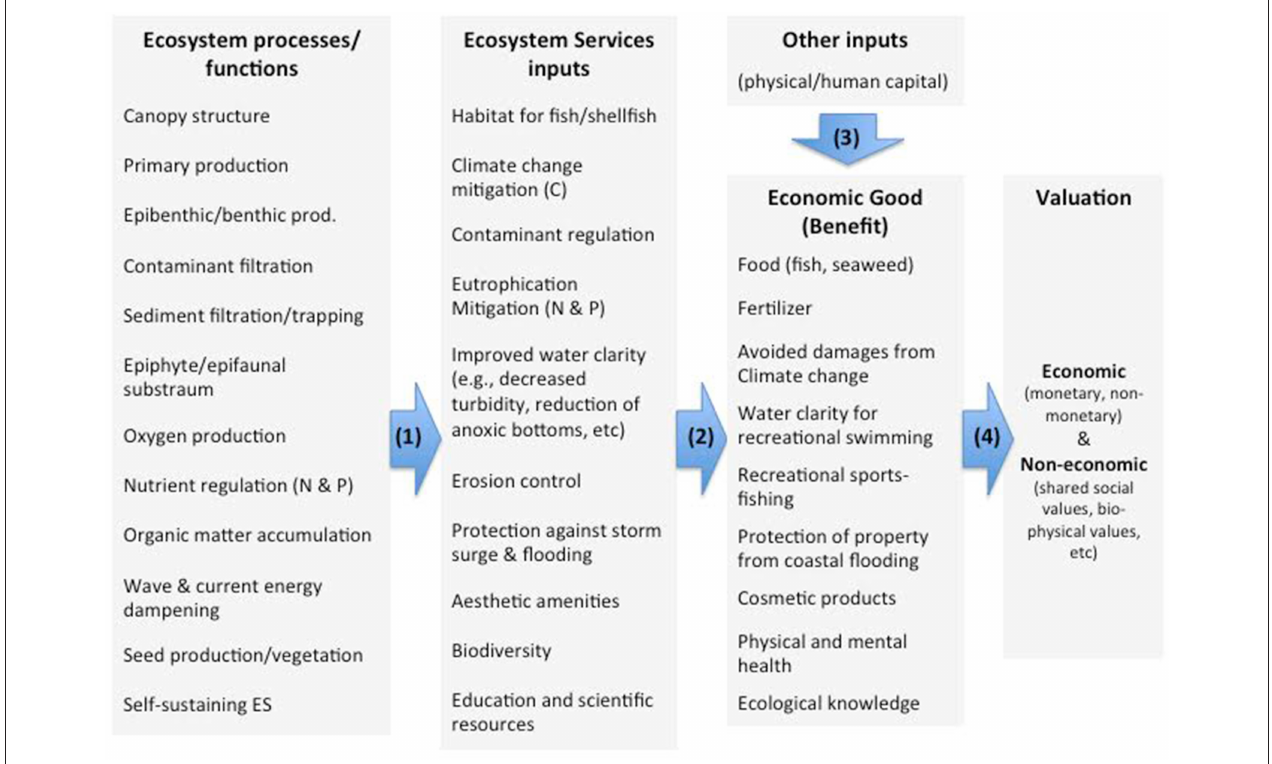
FIGURE 1 | Conceptual approach to identifying and valuing seagrass benefits to society. We follow a four step process: Step #1 maps relevant ecosystem functions and links them to economic goods [arrows (1) and (2)]. Step #2 identifies biophysical changes in ecosystem functions [first column] that are to be valued and Step #3 identifies how these changes affect the flow of multiple ecosystem services and economic goods [arrows (1) and (2)]. Finally, step #4 estimates the value of these multiple changes in economic goods [arrow (4)], which may also be affected by other non-ecosystem inputs [arrow